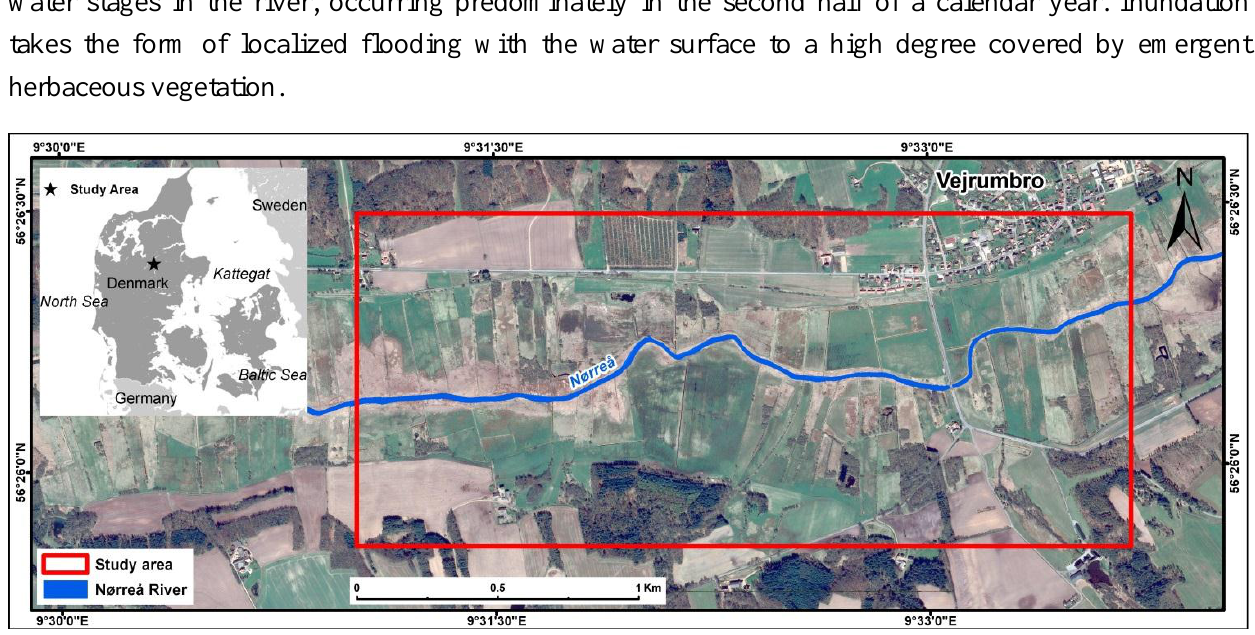
Figure 2. Project study area covering a part of the Nørreå river valley,